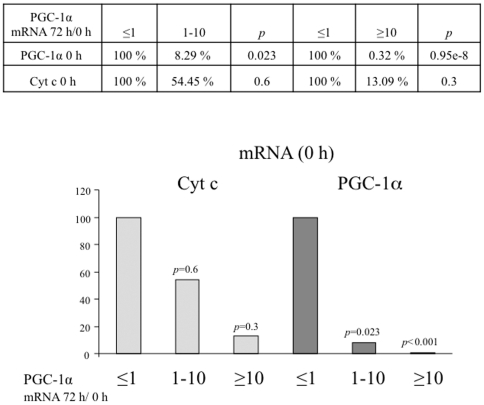
PGC-1α induction after STEMI negative correlates with PGC-1α basal levels.The graph shows average Cyt C and PGC-1α mRNA levels at the time of hospital admission in the three groups of PGC-1α induction.